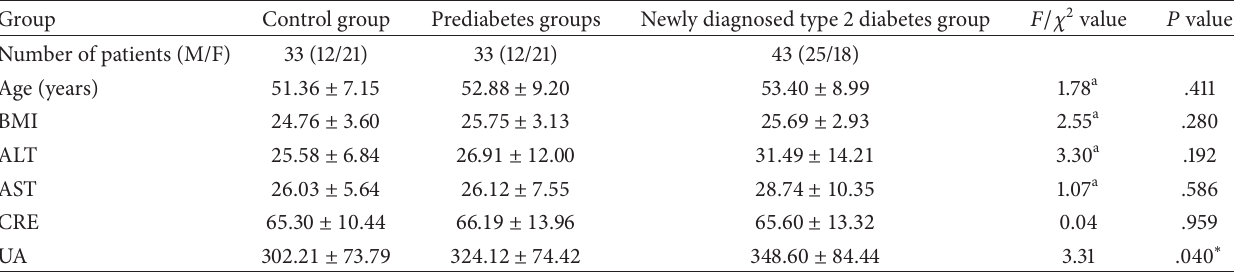
Table 1: Analysis of the general clinical data.